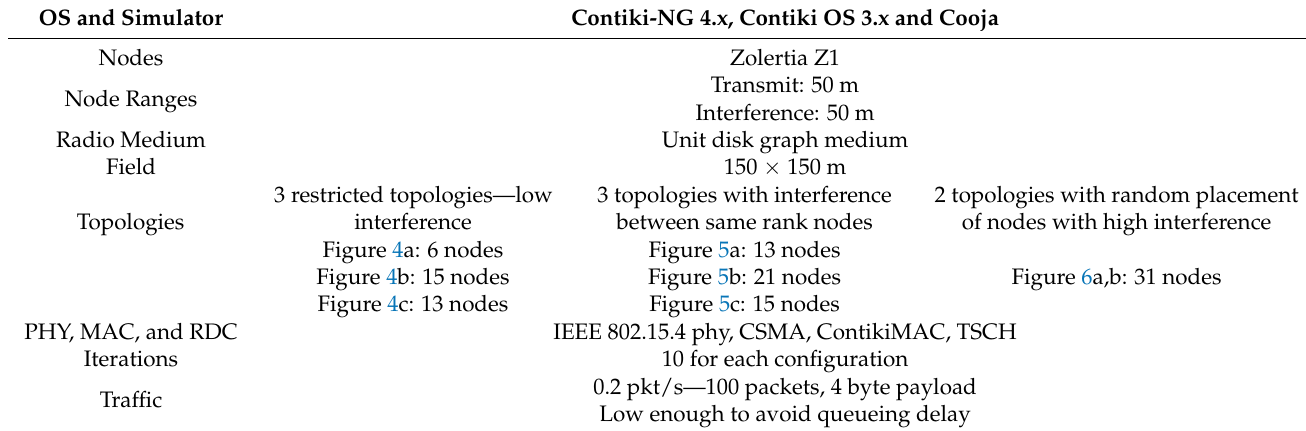
Table 1. Simulation configuration parameters and topologies summary. OS: operating system; MAC: medium access control; RDC: radio duty cycling.